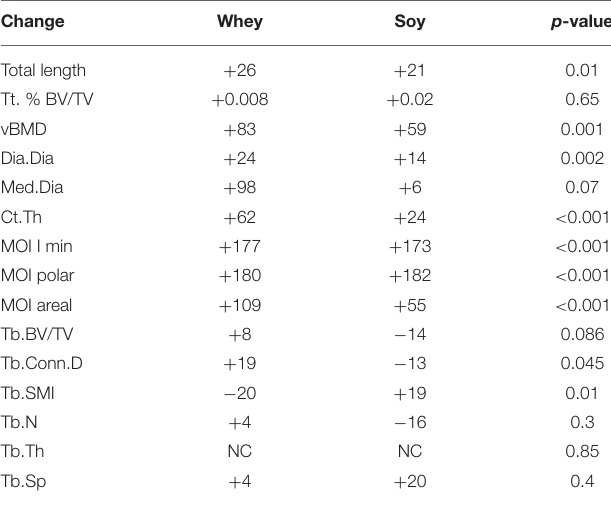
TABLE 4 | Age-dependent change in bone parameters ( µ CT) in male Sprague-Dawley rats depending upon the diet (values are ratio of 74/24 parameters and presented as percent